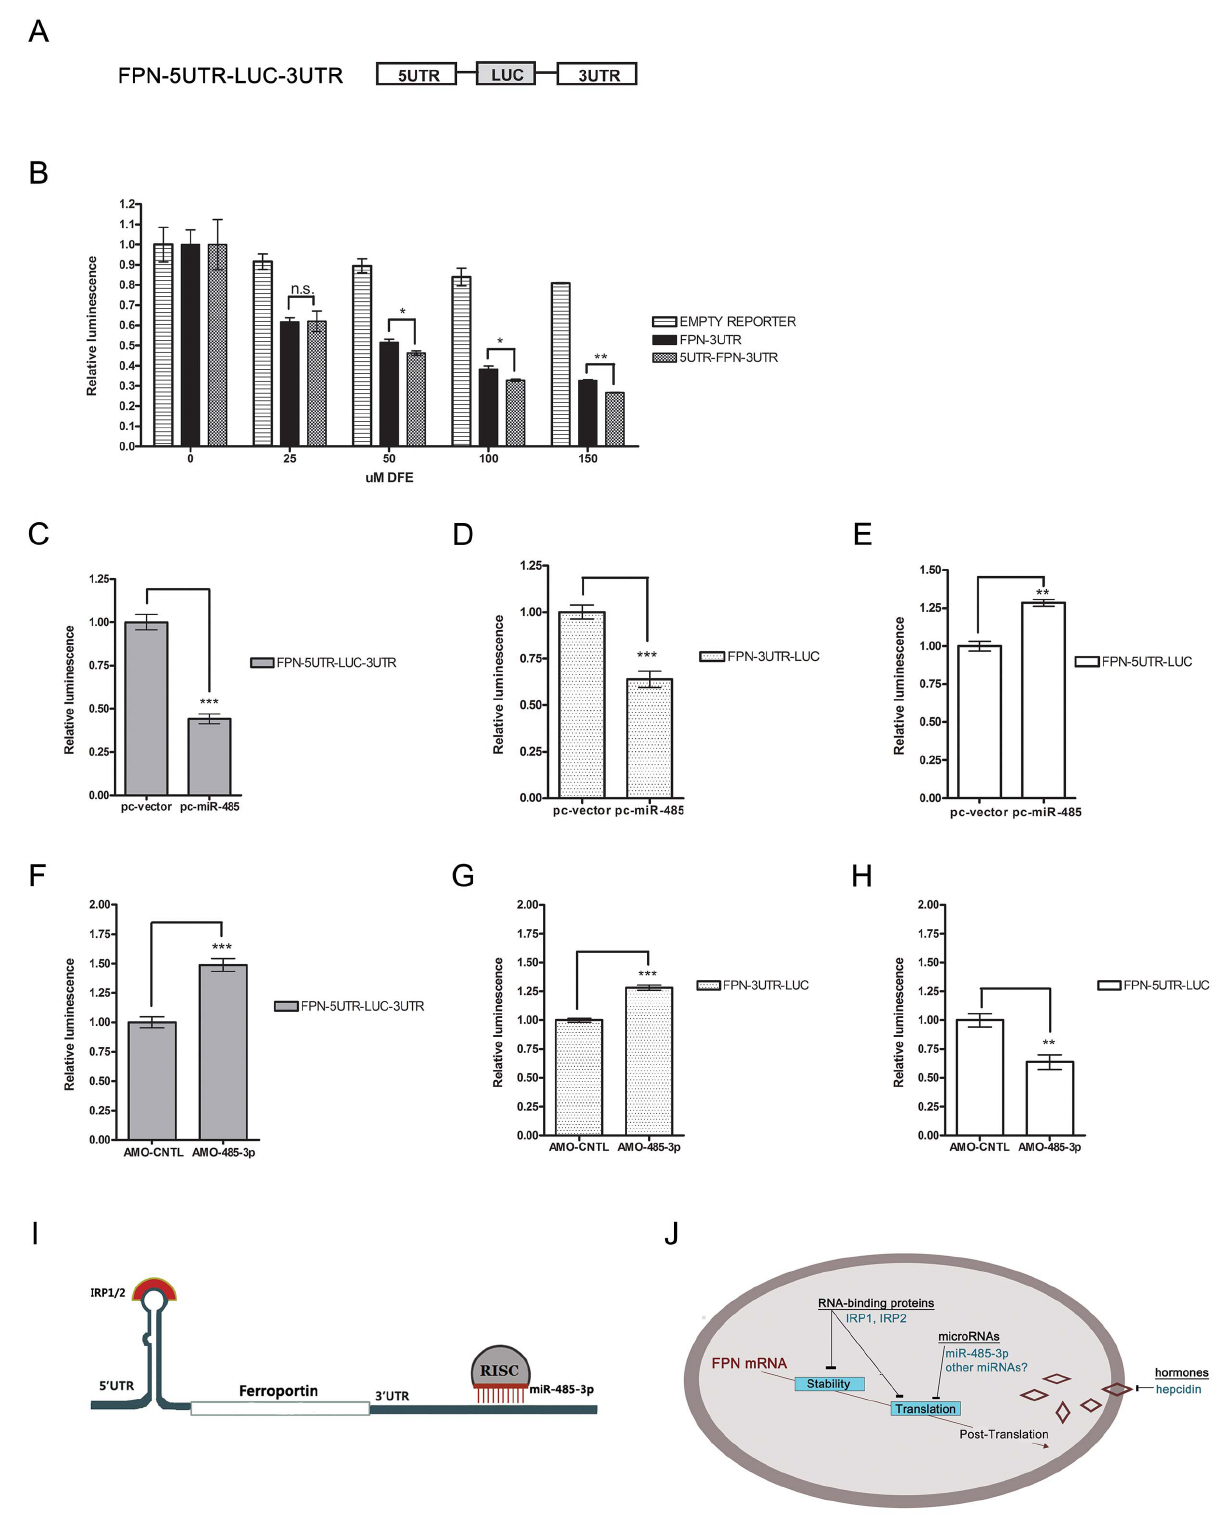
Figure 4. Both IRP-mediated 5 9 UTR and MiR-485-3p-mediated FPN 3 9 UTR to post-transcriptional regulation of FPN. (A) Schematic representation of FPN-5UTR-LUC-3UTR luciferase reporter construct. (B) Activity of FPN 3 9 UTR, 5UTR-LUC-3UTR, and empty control luciferase reporters in HepG2 cells following treatment with indicated concentrations of DFE. Data is expressed as fold change in luminescence 6 SEM relative to baseline condition (0 m M DFE) (n=3). (C–E) Activity of FPN 5 9 UTR reporter (C), FPN-5UTR-LUC-3UTR reporter (D), and FPN 3 9 UTR reporter (E) following overexpression of miR-485 (pc-miR-485) or vector control (pc-vector); expressed as fold change in luminescence 6 SEM relative to control samples (n=4). (F–H) Activity of FPN 5 9 UTR reporter (F), FPN-5UTR-LUC-3UTR reporter (G), and FPN 3 9 UTR reporter (H) following treatment with control (AMO-